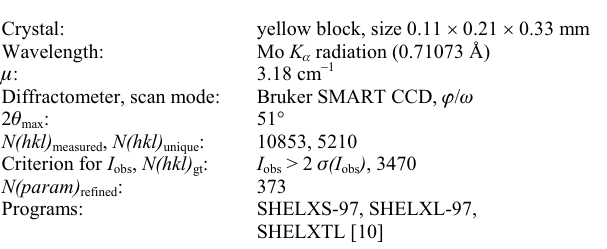
Table 1. Data collection and